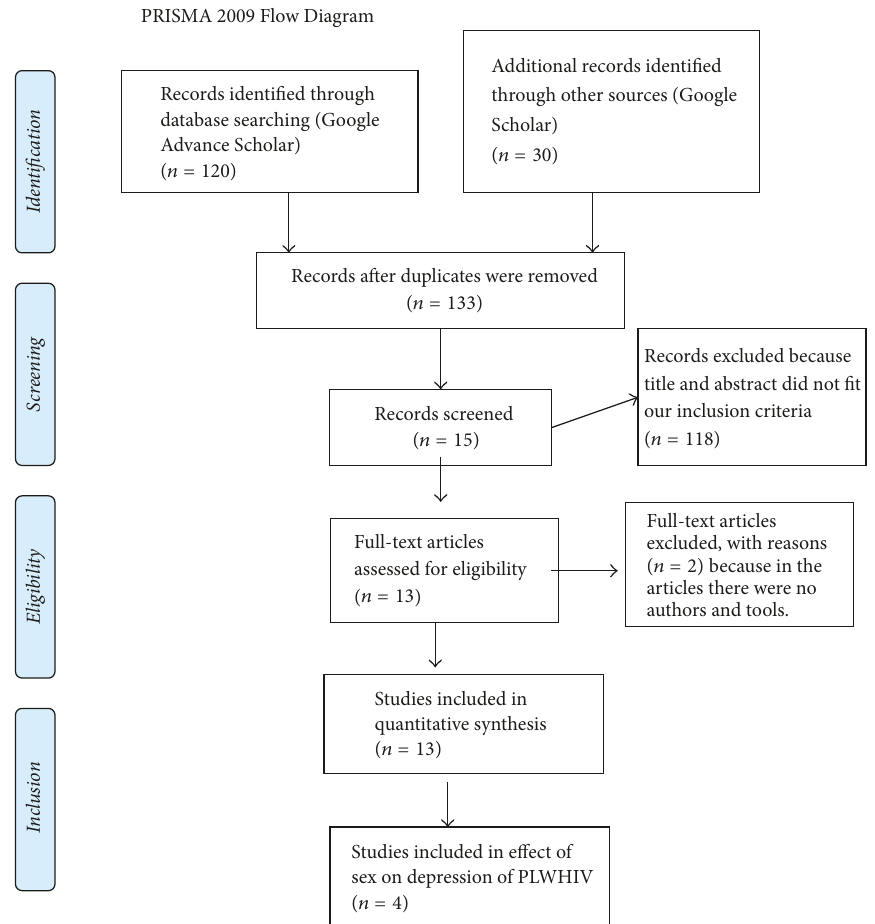
Figure 1: Flow chart showing how the research articles were searched (2017)